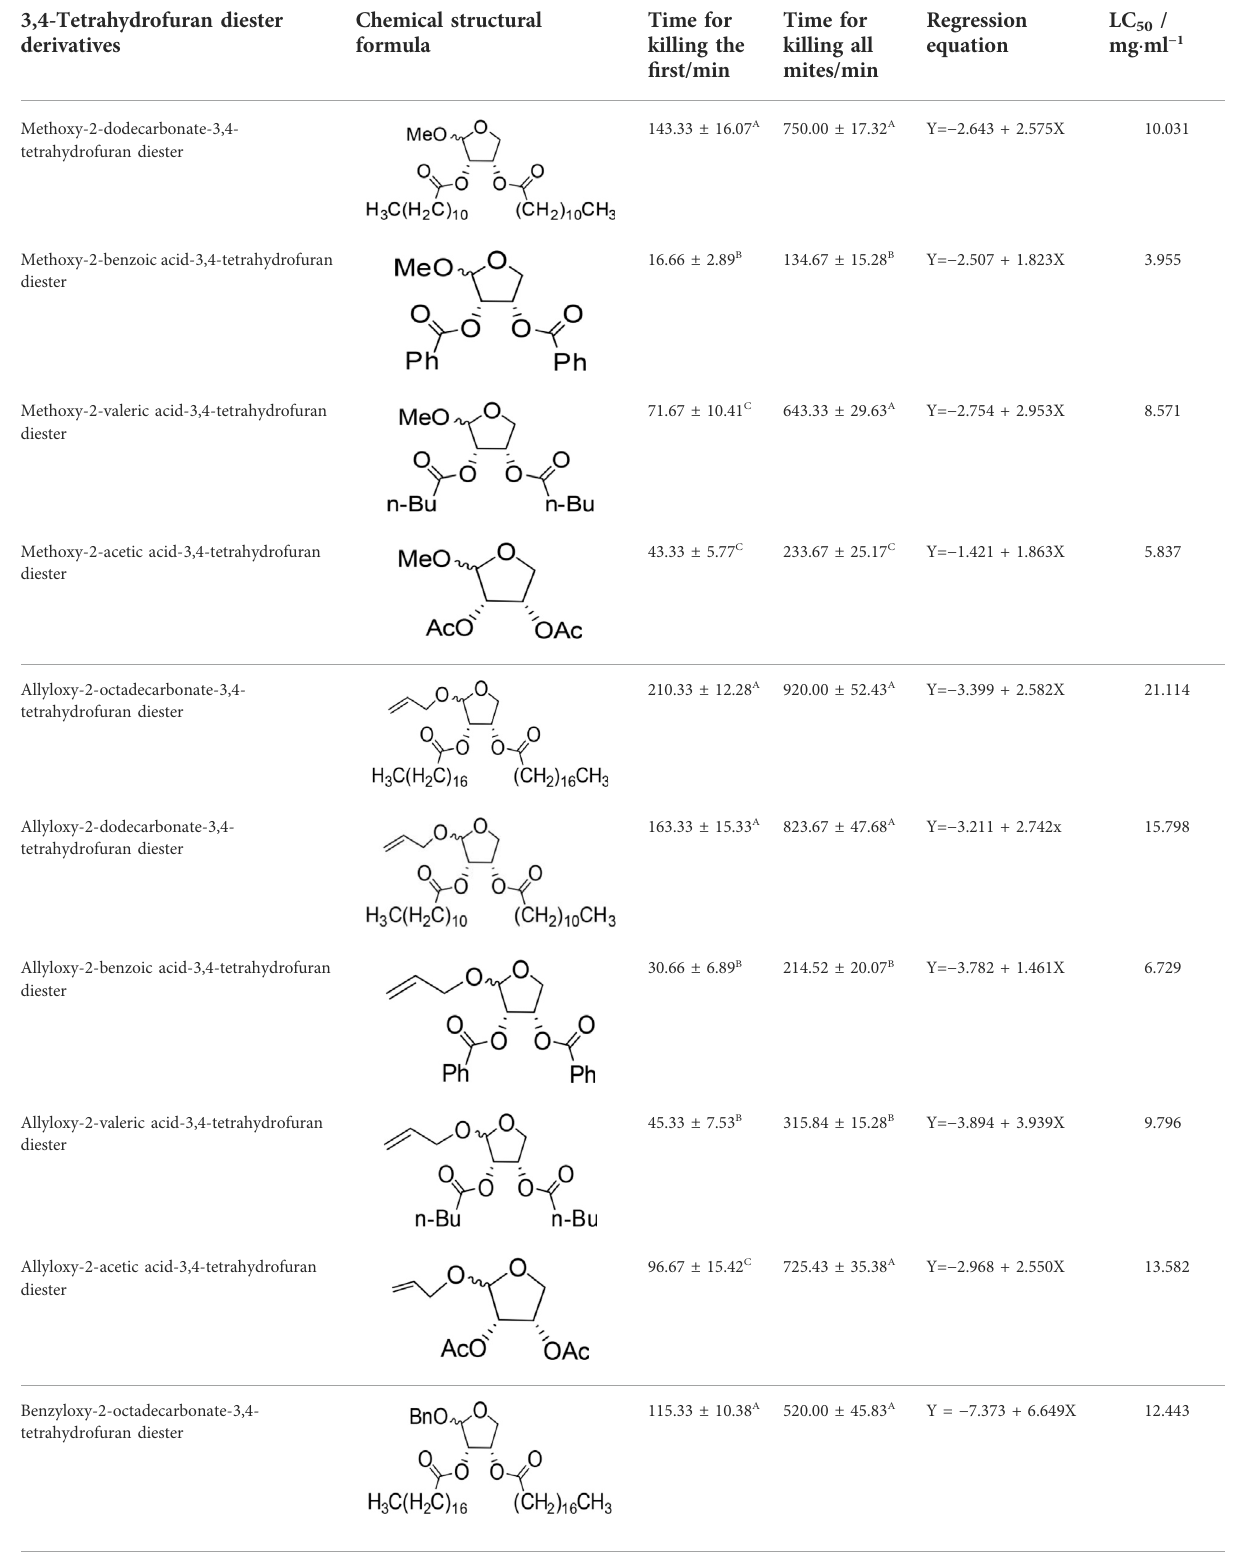
TABLE 1 In vitro acaricidal activity of 3,4-tetrahydrofuran diester